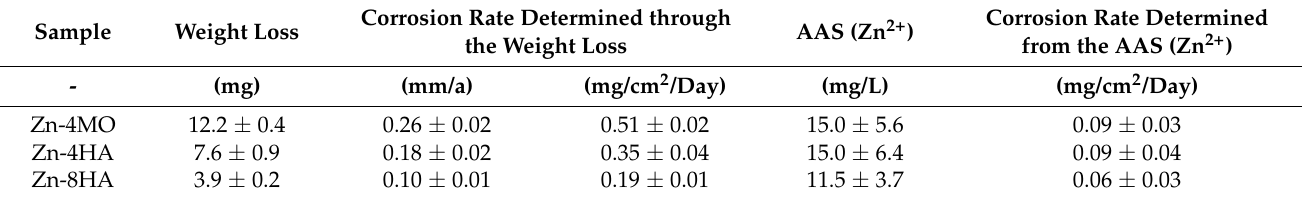
Table 6. Corrosion rates of the composites evaluated by weight loss and ion